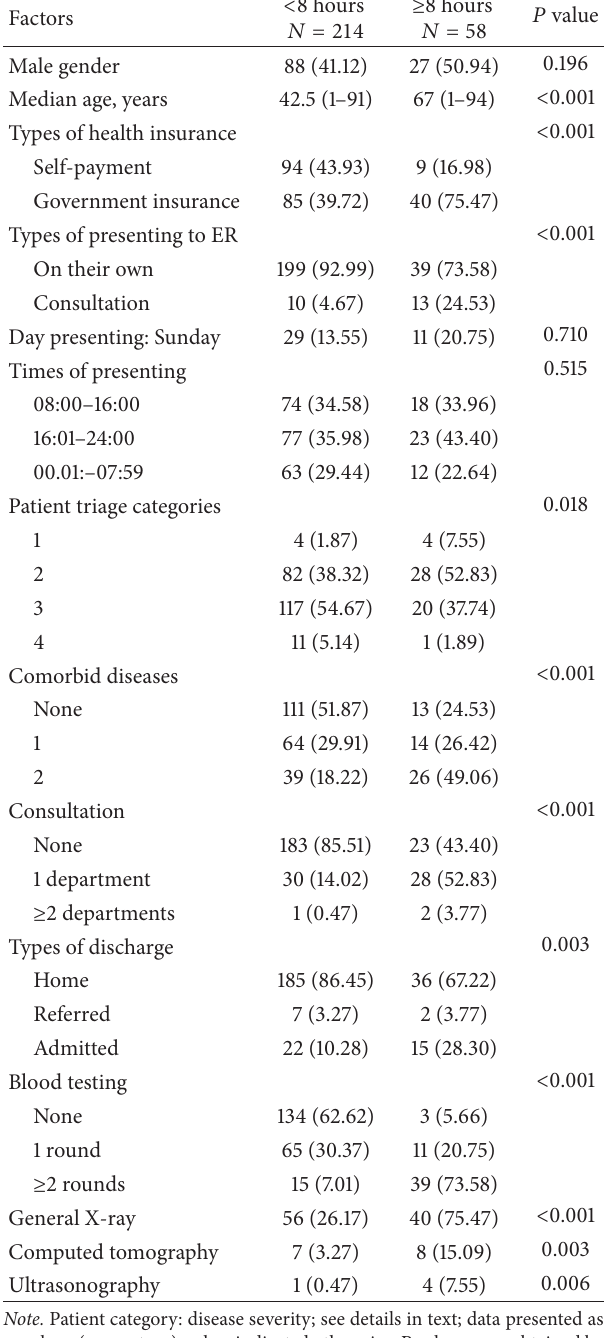
Table 2: Significant factors associated with prolonged stay more than or equal to 8 hours at the emergency department (ED) by univariate and multivariate logistic